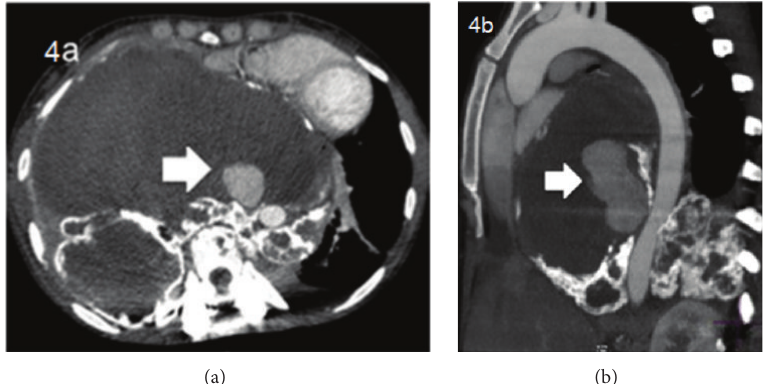
Figure 4: Postcontrast/arterial phase (a) and oblique reformatting (b) showing a pseudoaneurysm arising from the thoracic aorta and more prominent areas of calcification consistent with response to